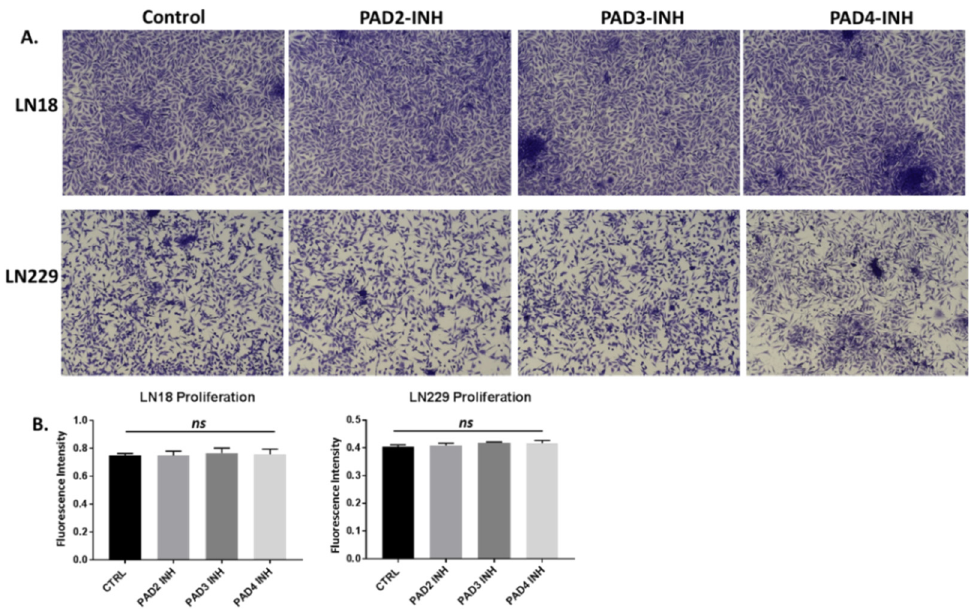
Figure 8. Cell proliferation assay for PAD isozyme-specific inhibitors in LN18 and LN229 GBM cells. ( A ). Representative images of LN18 and LN229 cells following 16 h treatment with the three PAD isozyme-specific inhibitors, compared to control (DMSO)-treated cells. ( B ) (imaged using a 10× objective). Chresyl violet assay revealed no significant effects (ns) of any of the three inhibitors on cell proliferation, following 16 h incubation, compared to control (DMSO)-treated cells ( n = 3 biological and 3 technical replicates for all).